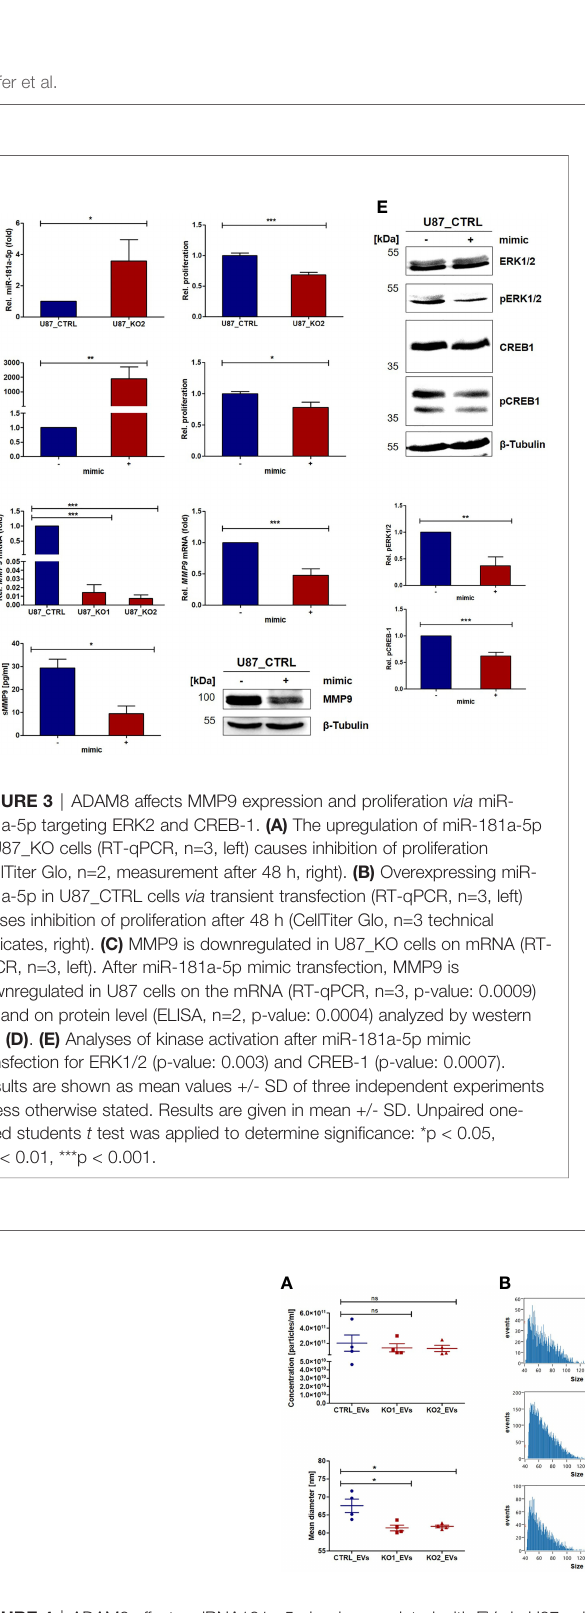
FIGURE 4 | ADAM8 affects miRNA181a-5p levels associated with EVs in U87 cells. (A) U87_CTRL and U87_KO derived EVs were characterized regarding their concentration (upper graph) and size (lower graph). Measurements were taken with the NanoFCM device and results are shown as mean values +/- SEM of four independent experiments. (B) Representative size distributions of U87_CTRL and U87_KO derived EVs (NanoFCM) are shown in bar graphs. (C) Via western blot, the presence of EVs was con fi rmed. CALNEXIN was used as negative control and FLOTILLIN-1 as well as CD81 as EV markers. (D) MiR-181a-5p is detectable in U87 derived EVs. RT-qPCR results show a non-signi fi cant tendency of miR-181a-5p upregulation in U87_ KO derived EVs. Mean values +/- SD of three independent experiments if not otherwise stated. Unpaired two-tailed students t-test was applied to determine signi fi cance: ns, not signi fi cant, *p <